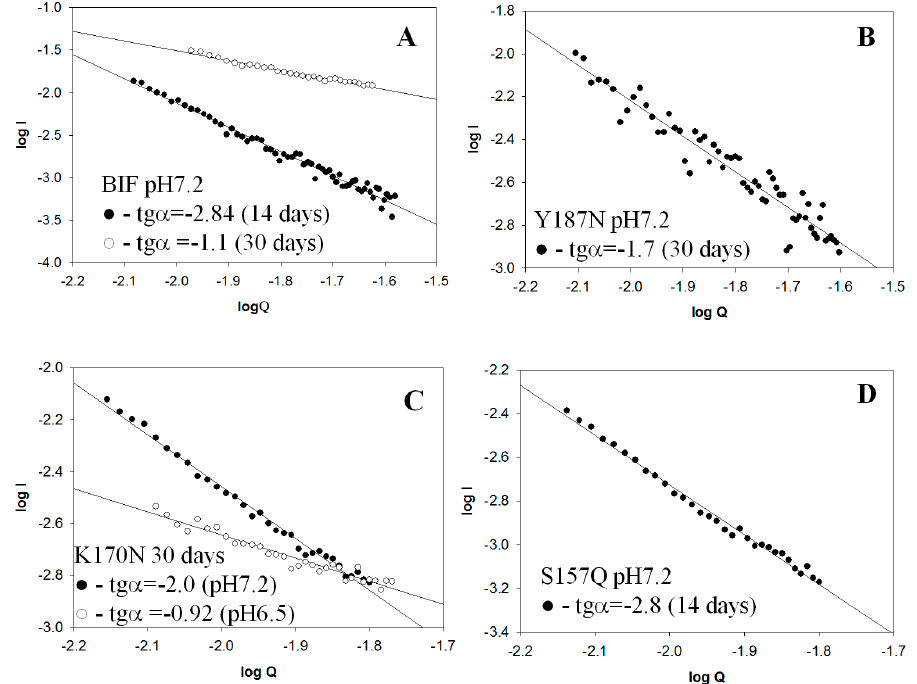
Figure 16. SAXS patterns (LogI vs. LogQ): ( A ) BIF at pH 7.2 after 14 and 30 days of incubation at 37 °C; ( B ) Y187N at pH 7.2 after 30 days of incubation at 37 °C; ( C ) K170N at pH 7.2 and 6.5 after 30 days of incubation at 37 °C; ( D ) S157Q at pH 7.2 after 14 days of incubation at 37 °C.